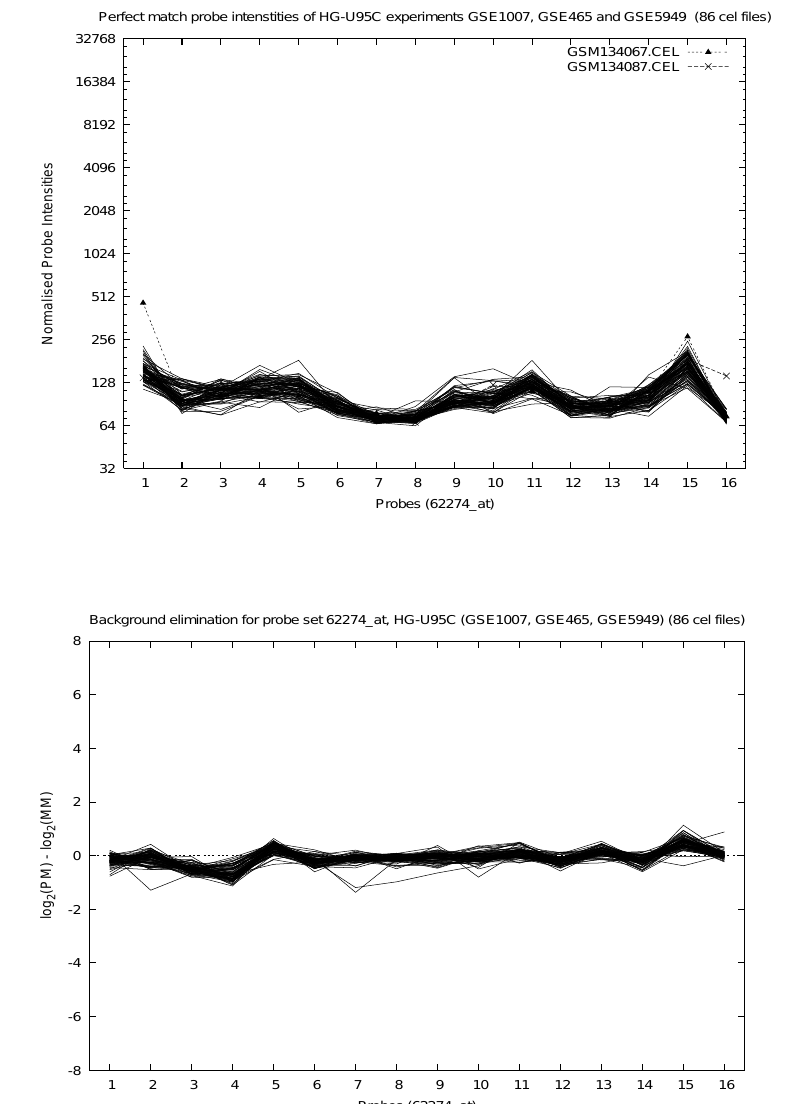
Figure 3: Probe intensities for experiments GSE1007, GSE465, GSE5949 of probe set 62274 at on the HG U95C array (A) Perfect match intensities (log scale) (B) Background elimination (log 2 (PM) - log 2